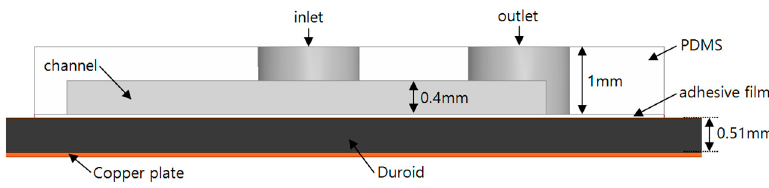
Figure 2. Side view of the proposed filter.